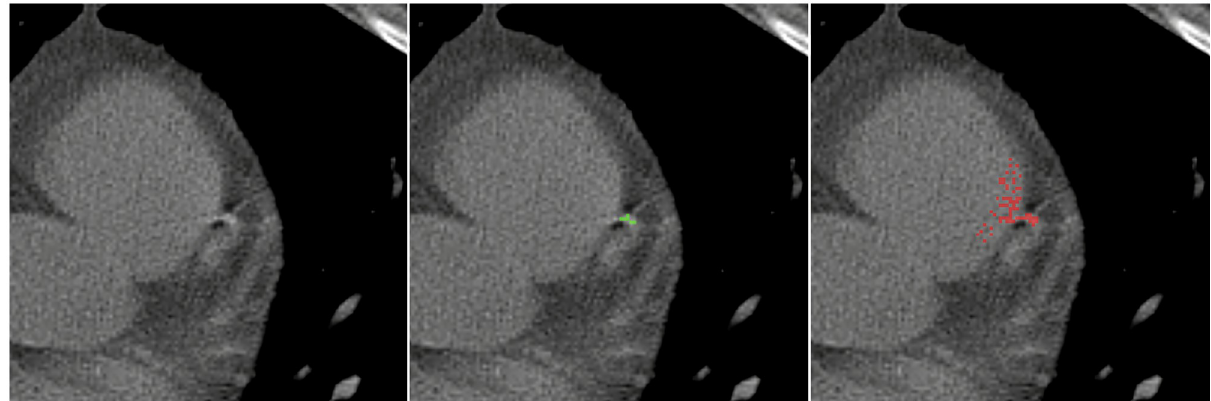
Fig 4. Left: Cropped CT slice containing CAC lesion; Middle: Segmented CAC lesion � 130 HU (green); Right: Segmented region using � 90 HU around the CAC lesion (red).